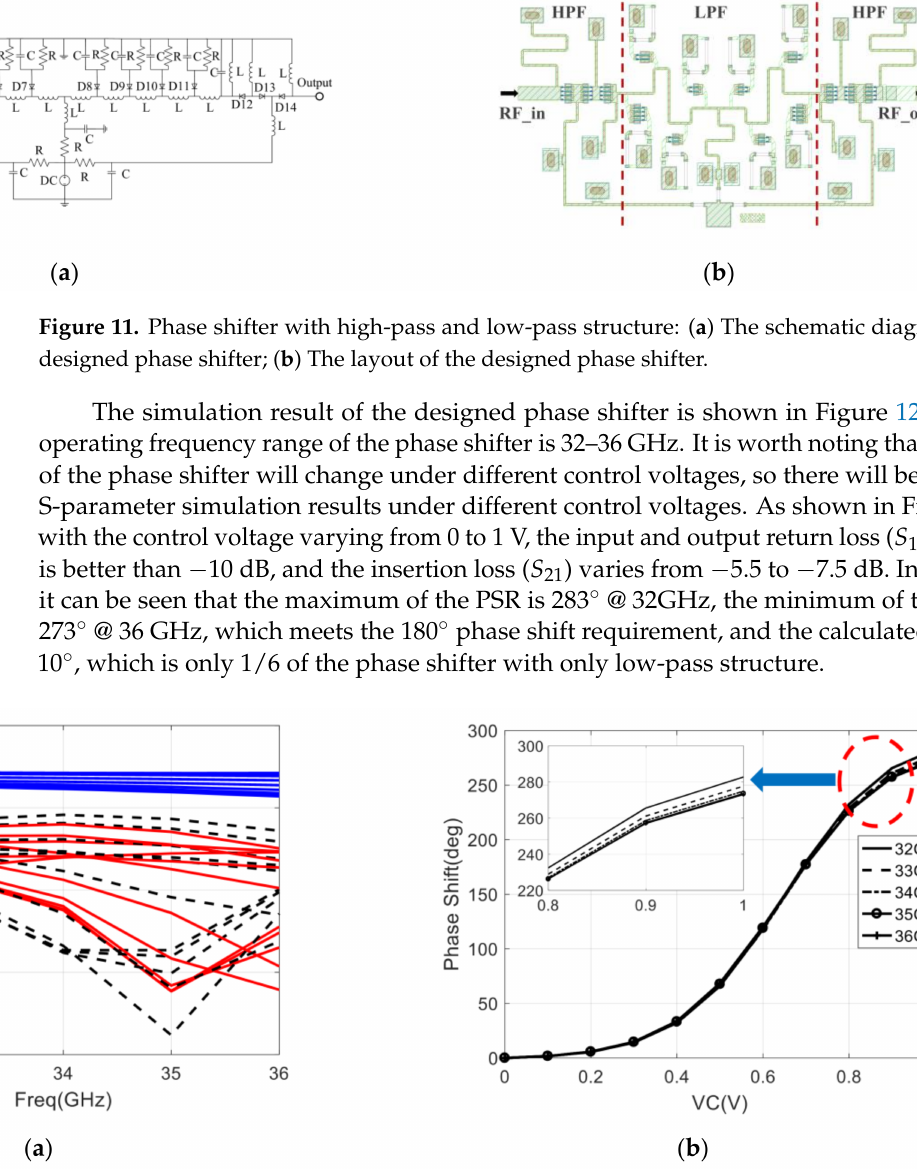
Figure 12. Simulation of the phase shifter: ( a ) The return loss and the insertion loss with the control voltage varying from 0 to 1 V; ( b ) Phase shift